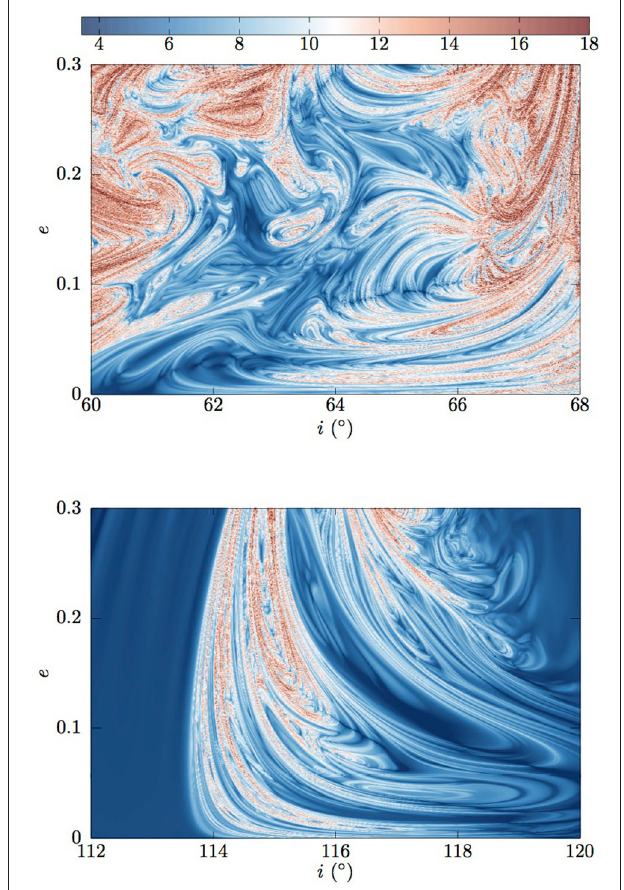
FIGURE 4 | Two detailed views of the phase space under the FLI analysis. 701 701 orbits have been propagated revealing the existence of very thin × structures and KAM tori filling the chaotic regions. On this domain, the retrograde region contains 4 time less orbits satisfying the condition α log (run), α FLI( τ run ) ≥ =